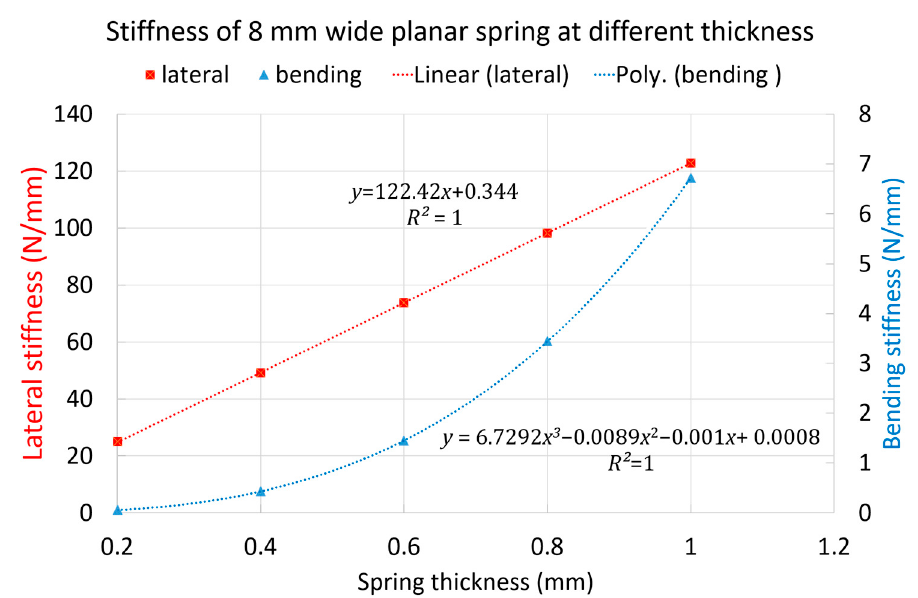
Figure 8. Lateral and bending stiffness of the module for different thicknesses. Poly: third degree polynomials.